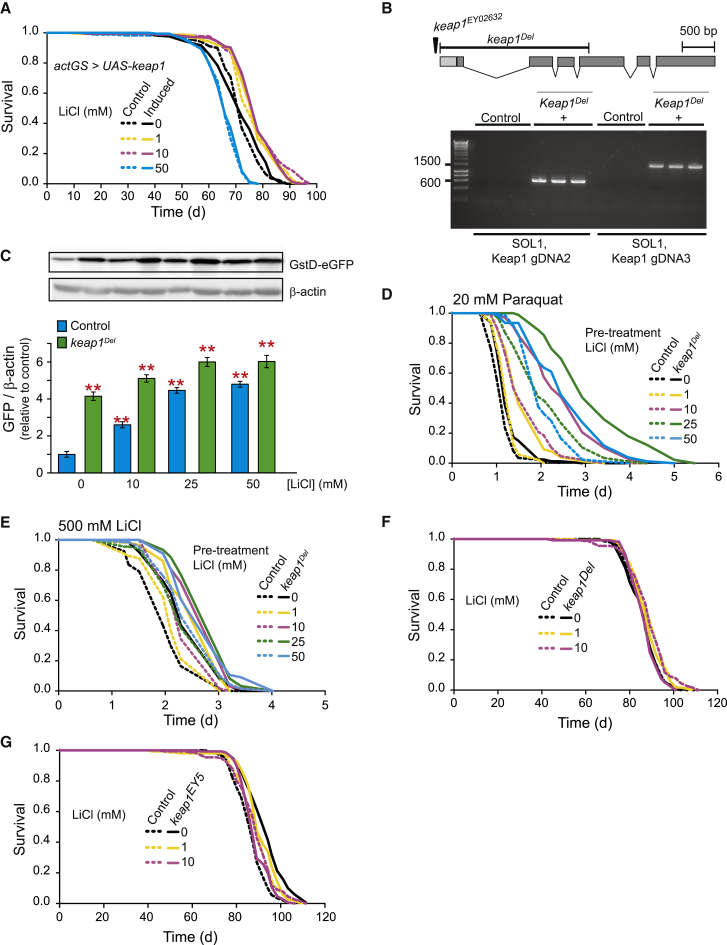
Higher Activation Levels of CncC Promote Xenobiotic Resistance but Not Lifespan(A) Overexpression of keap1 did not prevent the lifespan-modulatory effects of lithium treatment. n = 150 flies per condition.(B) Schematic of the keap1 gene showing the portion deleted in the keap1Del mutant (top) and agarose gel showing start and end of P-element disrupting keap1 coding sequence in the keap1Del mutant (bottom).(C) Combination of heterozygous deletion of keap1 and lithium treatment showed a greater activation of CncC than on their own. Bars represent means of four replicas of five flies per repeat ± SEM. ∗∗p < 0.01.(D) Deletion of keap1 in flies treated with lithium showed greater protection against paraquat than either treatment on its own, with maximal effects observed at 25 mM (p < 0.001).(E) The keap1 deletion protected against toxic concentrations of lithium (500 mM), and this protection was augmented with lithium pre-treatment (p < 0.01).(F) Deletion of keap1 did not extend lifespan: 1 mM lithium (p < 0.05), but not 10 mM (p > 0.05), treatment of keap1 flies resulted in a small but significant extension. n = 150 flies per condition.(G) keap1EY5 mutant flies showed significant lifespan extension (p < 0.001), that was dose-dependently abolished (p > 0.05) by lithium, likely as a result of over-activation of CncC. n = 150 flies per condition.